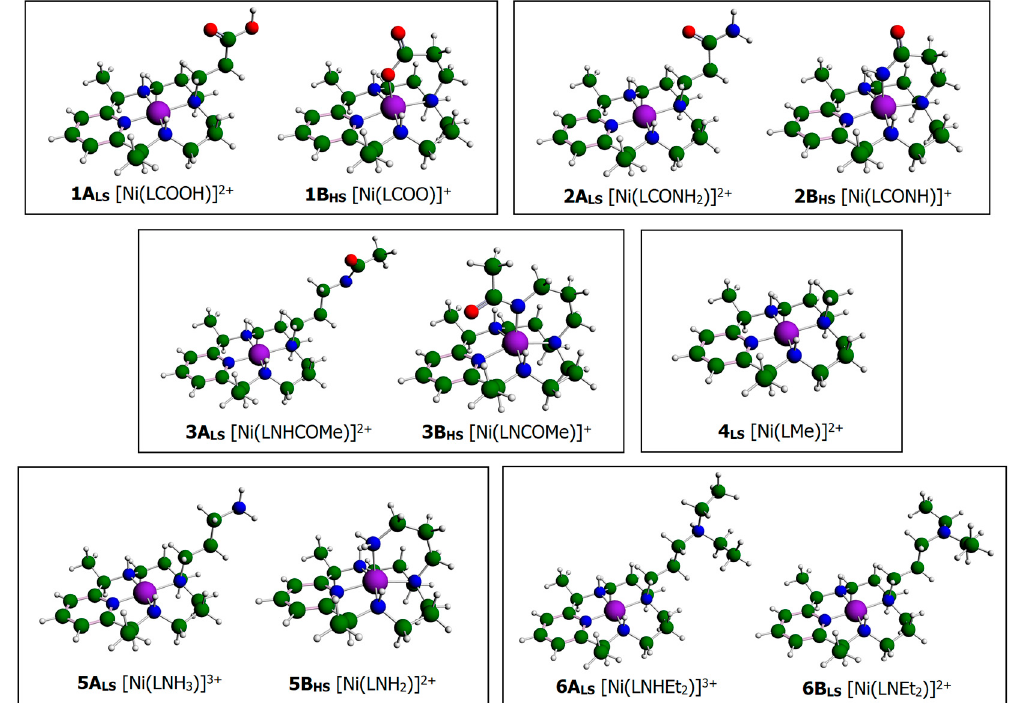
Figure 2. Density functional theory (DFT)-optimized electronic ground states of Ni(II)–PyMAC complex cations 1 – 6 using BLYP functional [where: green—carbon, blue—nitrogen, red—oxygen, white—hydrogen, and purple—nickel]. A and B denote protonated and deprotonated forms, respectively (except model 4 ). Corresponding spin states are indicated as subscripts, LS or HS . BLYP: Becke ‐ Lee ‐ Yang ‐ Parr. Table 1. High ‐ spin/Low ‐ spin bond energy splitting (kcal mol − 1 ) in 5B complex as derived from single ‐ point calculations at selected exchange ‐ correlation (XC) functionals. A positive value in energy splitting indicates that the predicted ground state is high ‐ spin.